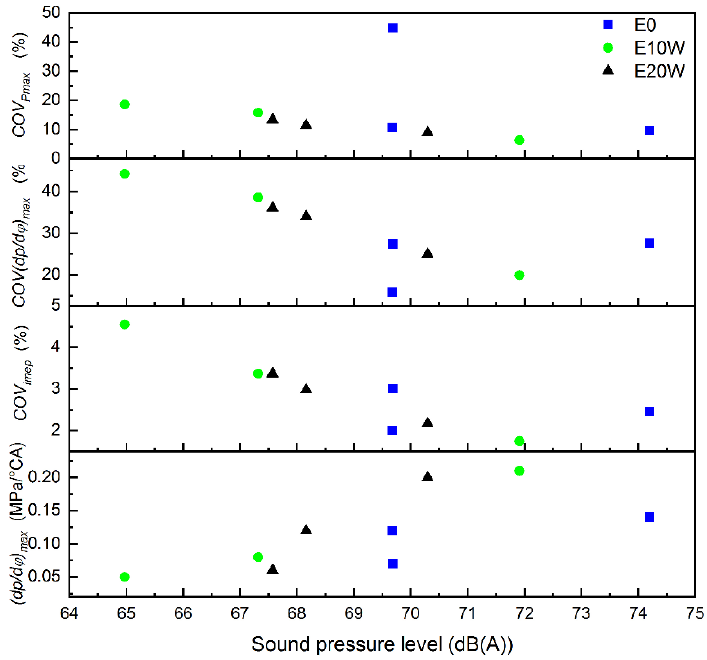
Figure 9. The relationship between noise emission level and combustion parameters.